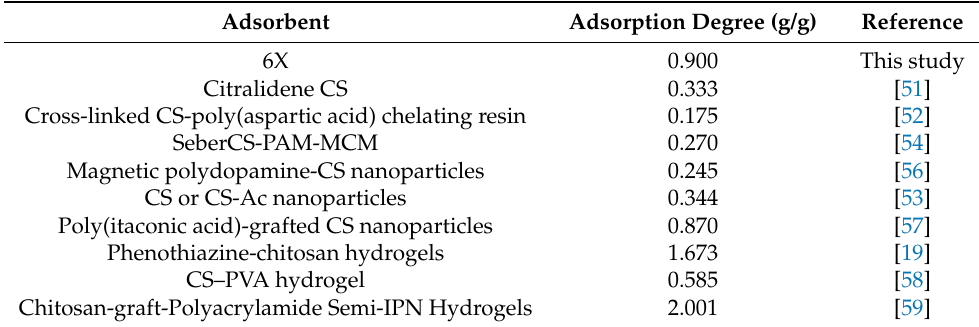
Table 1. Comparative analysis of the mercury adsorption capacity of the studied samples with other chitosan-based materials reported in the